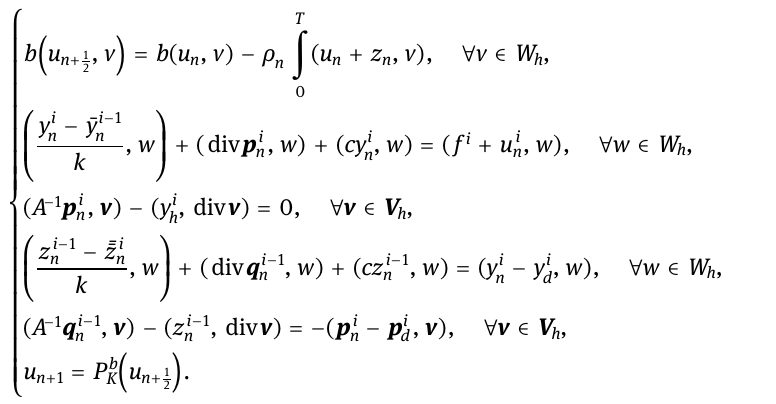
Algorithm 4.1. Projection gradient